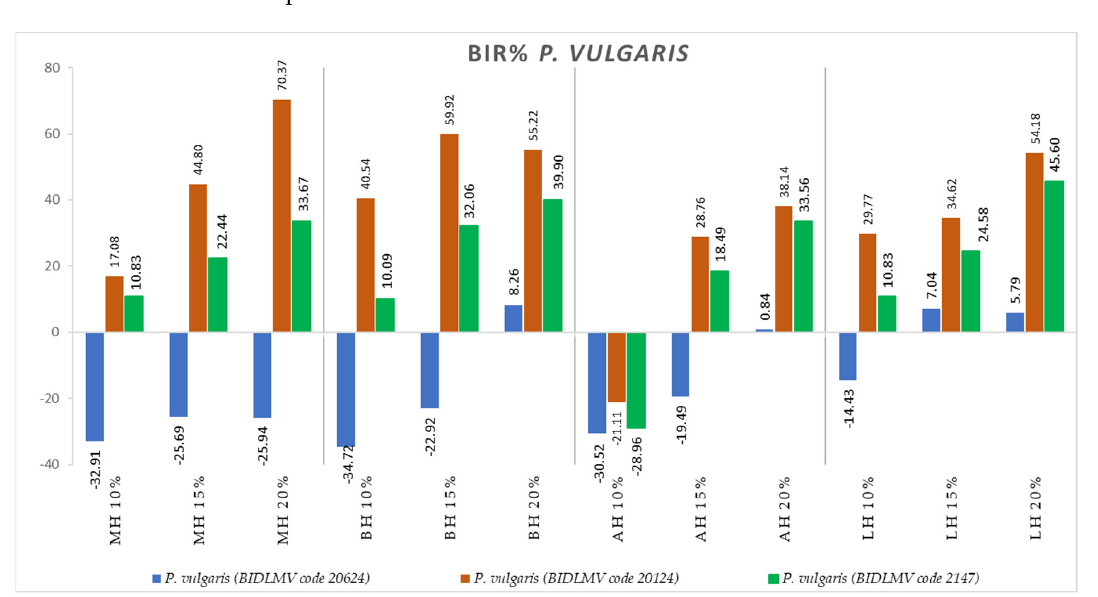
Figure 10. Antimicrobial activity (expressed as BIR%) of honey samples tested on P. vulgaris isolates.